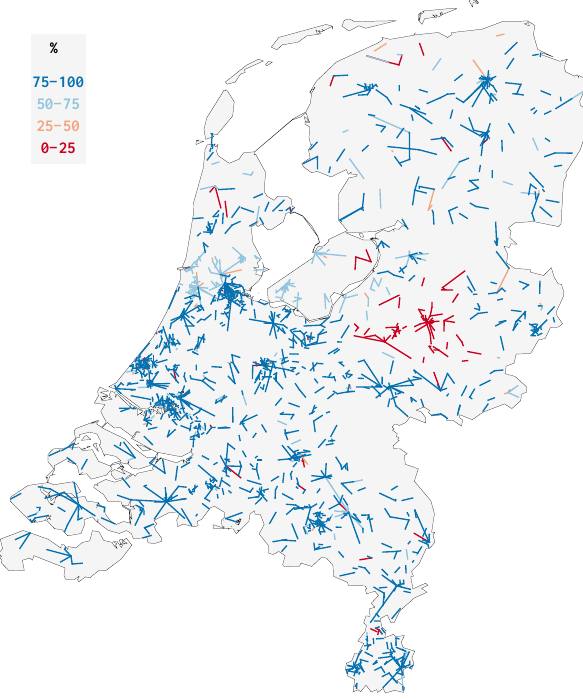
Figure 3. Topology of the T-Mobile NL microwave link network used for this study. The colour scale of the microwave network rep- resents the temporal availability of the link data for the 12-day val- idation period. The average availability is